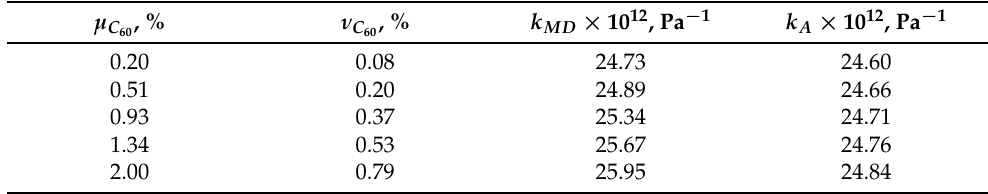
Table 2. Influence of the fullerene concentration on the compressibility of the aluminum melt. Comparison of analytical estimates, k A , and calculations by the MD method, k MD